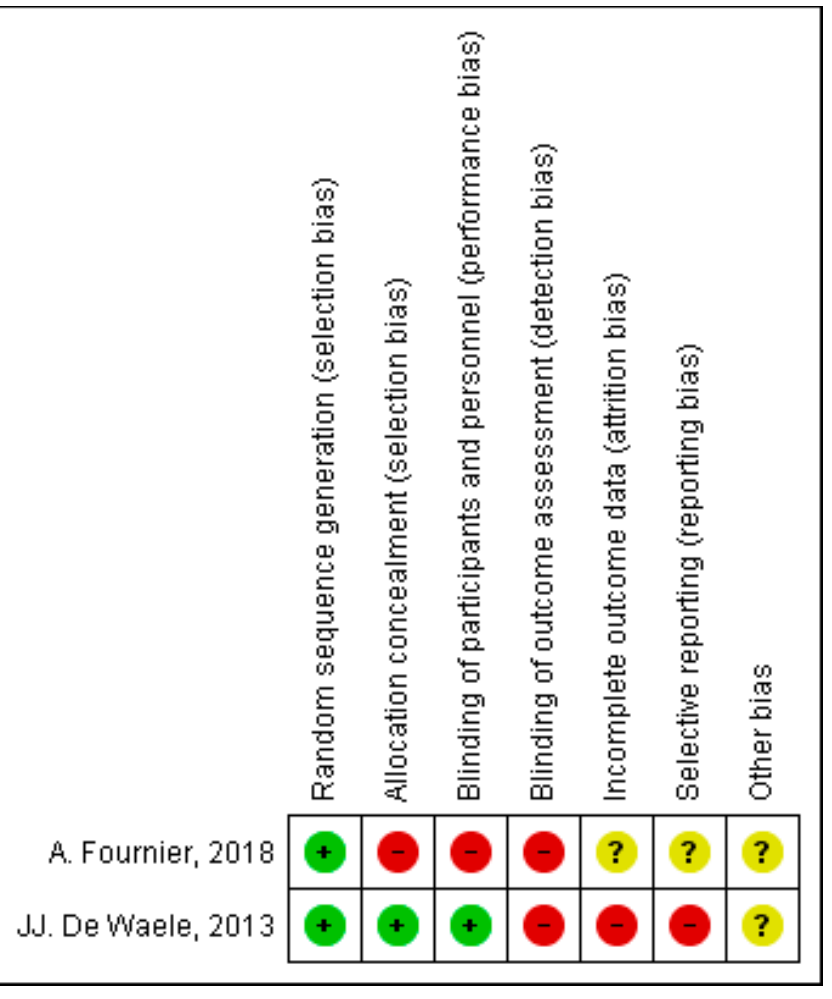
Figure 4. Summary of risk of bias in selected studies (Cochrane Risk of Bias Tool for randomized controlled trials). Table 3. Risk of bias in observational studies according Newcastle-Ottawa scale (NOS)